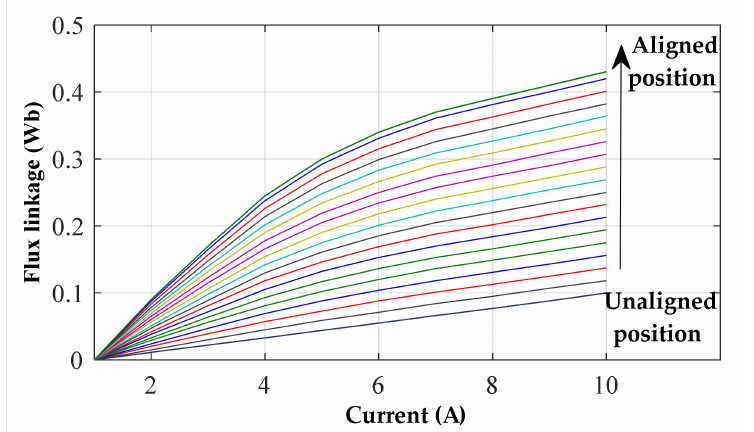
Figure 4. 8/6 SRG magnetization characteristics versus current at different rotor